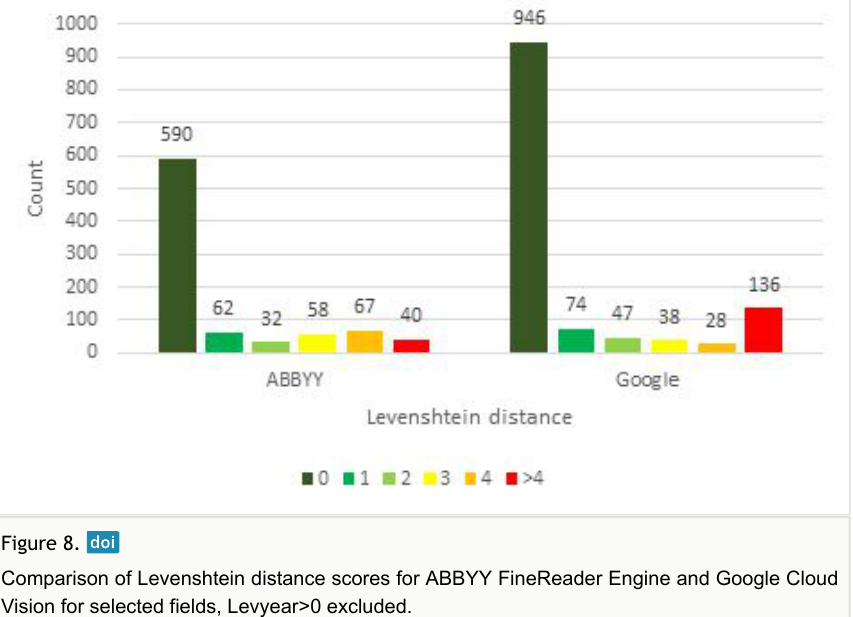
Comparison of Levenshtein distance scores for ABBYY FineReader Engine and Google Cloud Vision for selected fields, Levyear>0